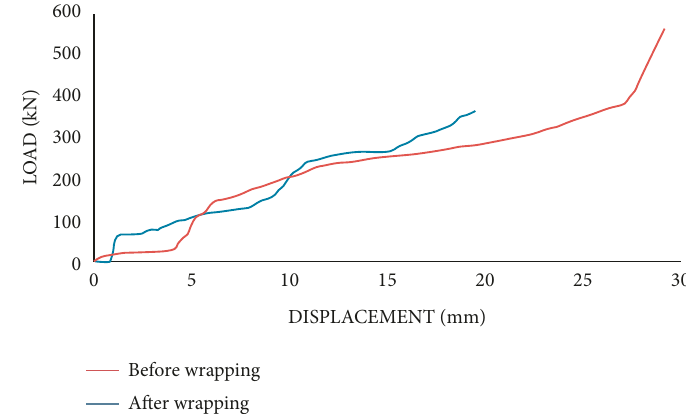
Figure 16: Load-deflection behavior of GG25 specimens before and after